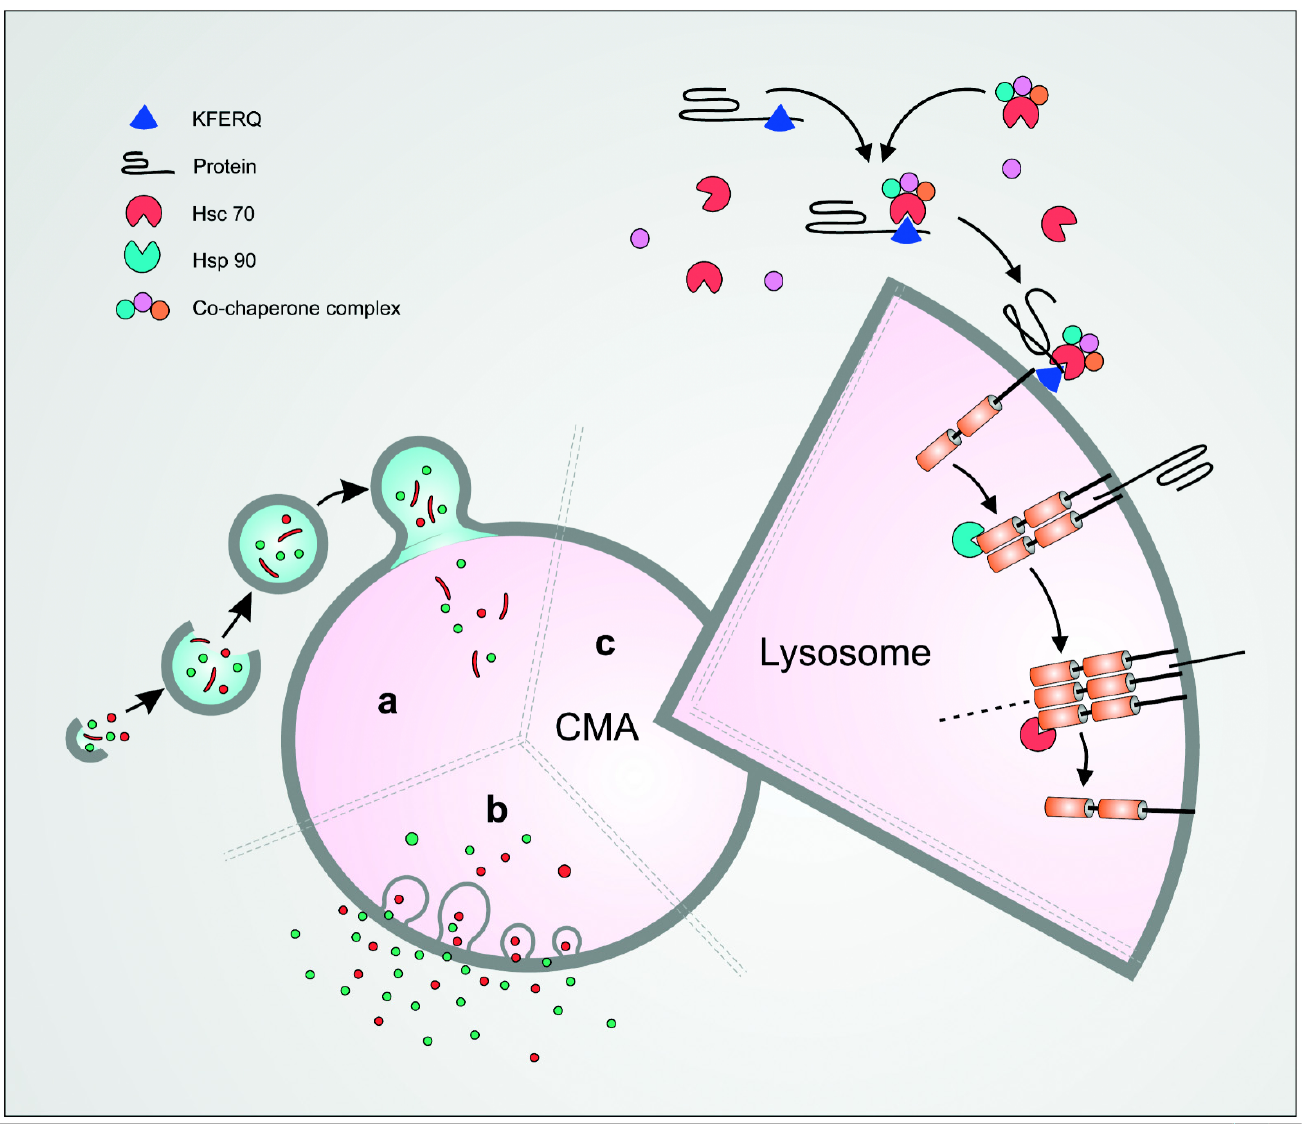
Figure 1. Schematic representation of the three main types of autophagy. Macroautophagy involves the sequestration of the cargo inside a double membrane vesicle—the autophagosome—followed by its fusion with the lysosomes ( a ). In microautophagy, an invagination of the lysosomal membrane occurs into which the substrate is engulfed ( b ). Chaperone-mediated autophagy (CMA) is a selective type of autophagy in which a protein bearing the KFERQ motif is recognised by the cytosolic chaperone Hsc70 and its co-chaperone complex. The complex is then targeted to LAMP-2A on the lysosomal membrane where it will unfold and translocate into the lysosome ( c ).